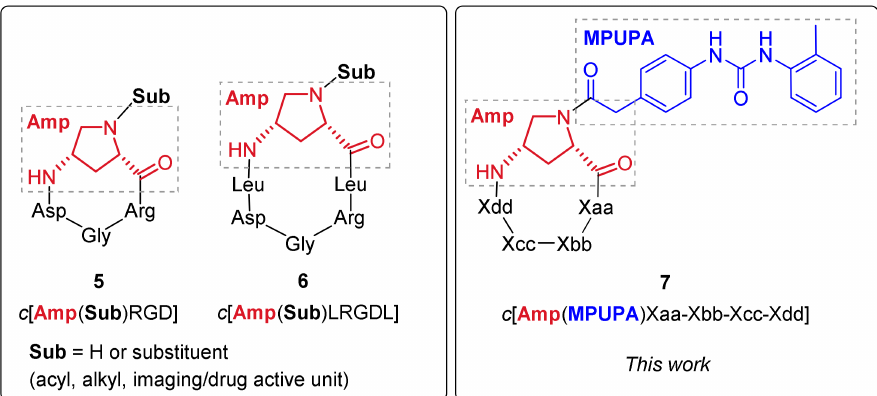
Figure 2. Amp-based cyclopeptides directed to RGD-recognizing α V β 3 , α V β 5 , and α V β 6 integrins (compounds 5 and 6 ) [30–40], and general structure of cyclopeptidomimetics 7 designed and synthe- sized to target α 4 β 1 integrin in the present